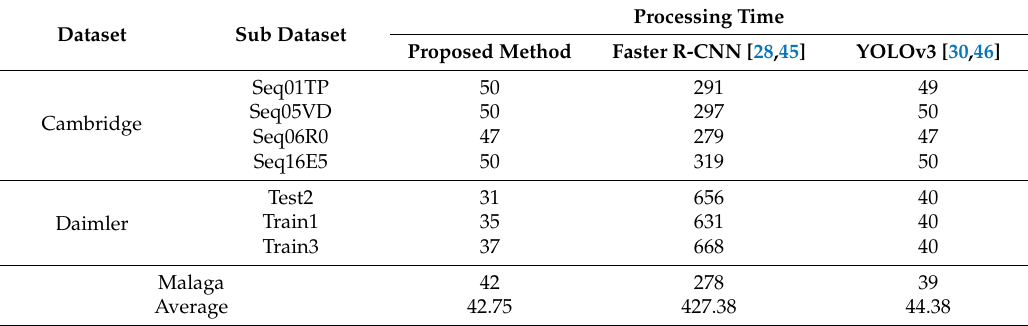
Table 9. Processing time per each frame in the desktop computer environment (unit: millisecond).